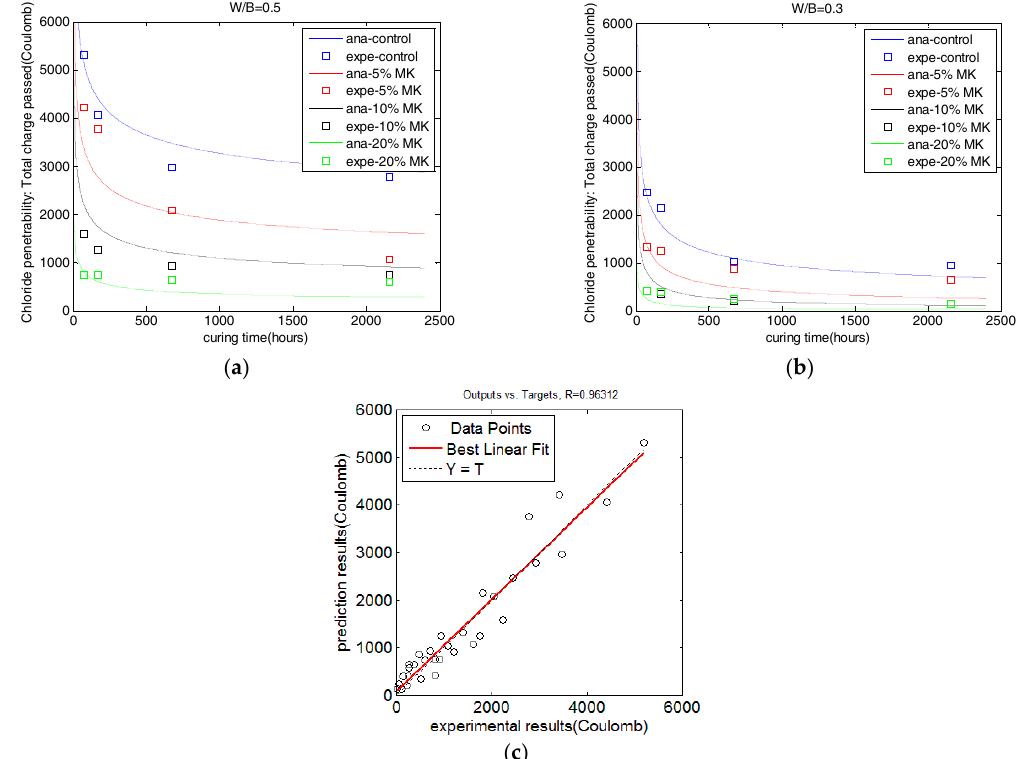
Figure 8. Evaluation of chloride penetrability. ( a ) water to binder ratio 0.5; ( b ) water to binder ratio 0.3; and ( c ) a comparison between the prediction results and the analysis results.